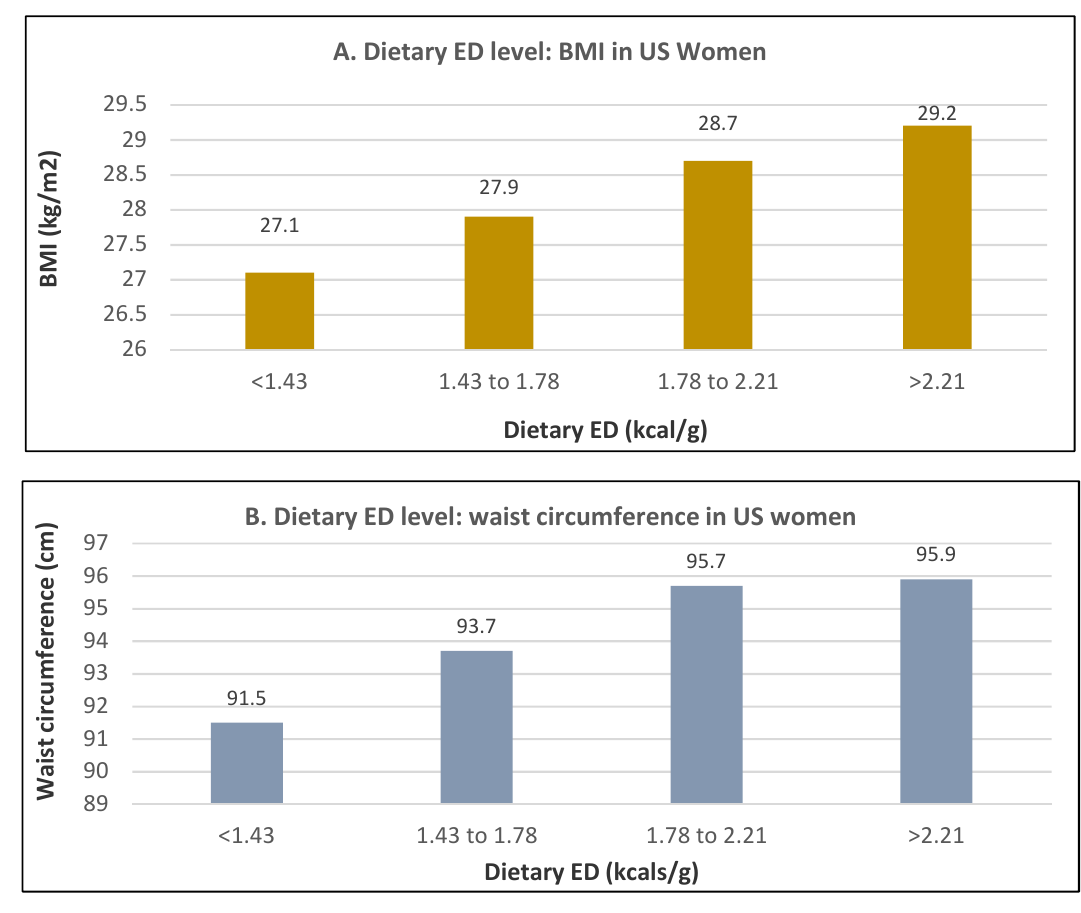
Figure 25. Multivariate adjusted association between dietary energy density (ED) and ( A ) BMI (mean SD ± 0.3 kg/m 2 ; p -trend < 0.0002) and ( B ) waist circumference (mean SD + mean SD ± 0.9 cm; p -trend < 0.001) from an NHANES analysis of 4587 US women (≥18 years) [73].